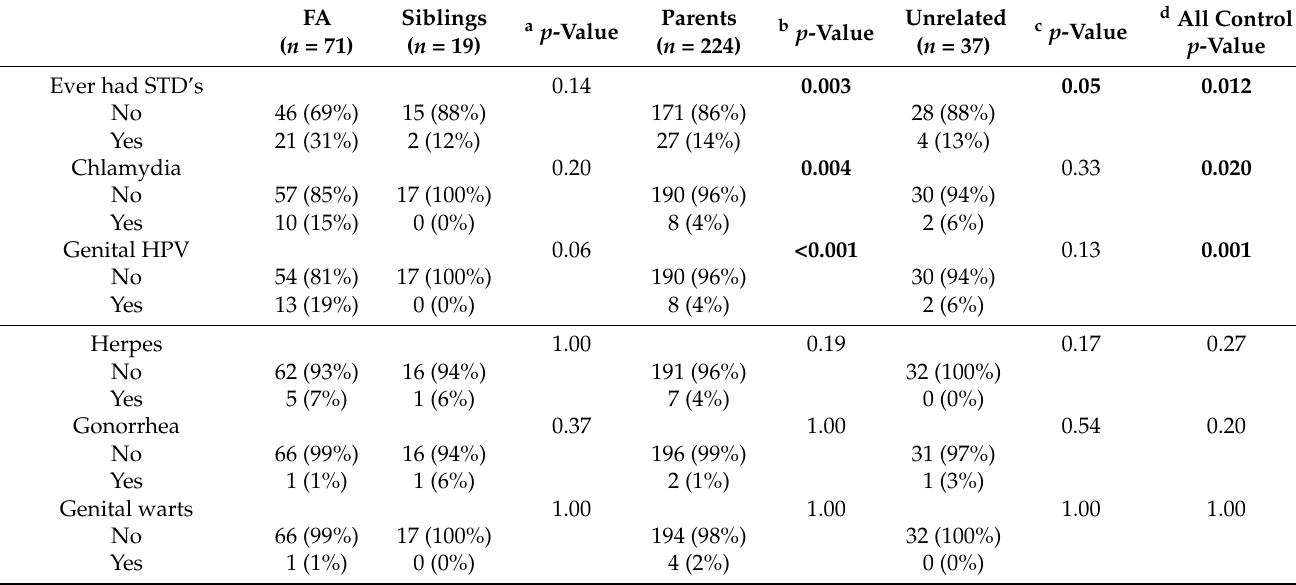
Table 4. Sexually Transmitted Disease History Among Sexually Active